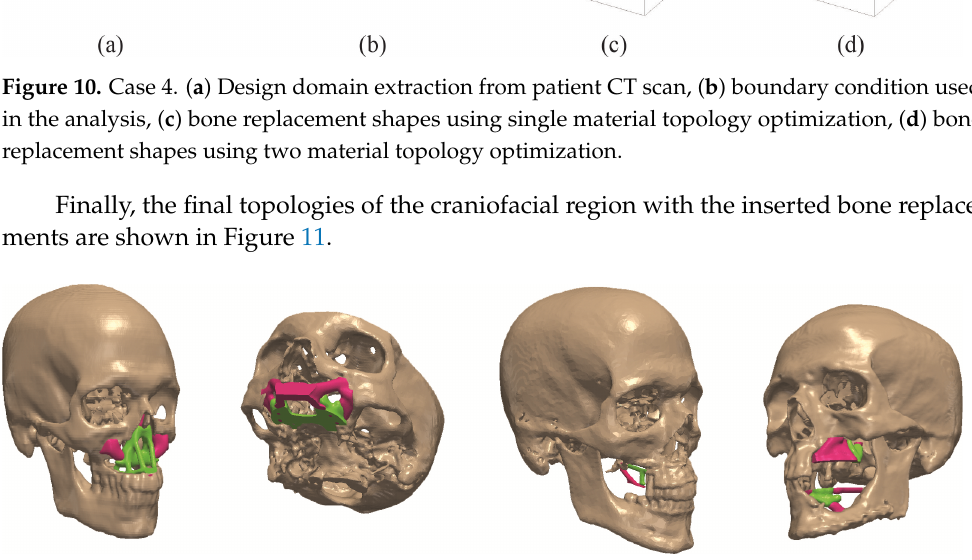
Figure 11. Bone replacements embedded in the